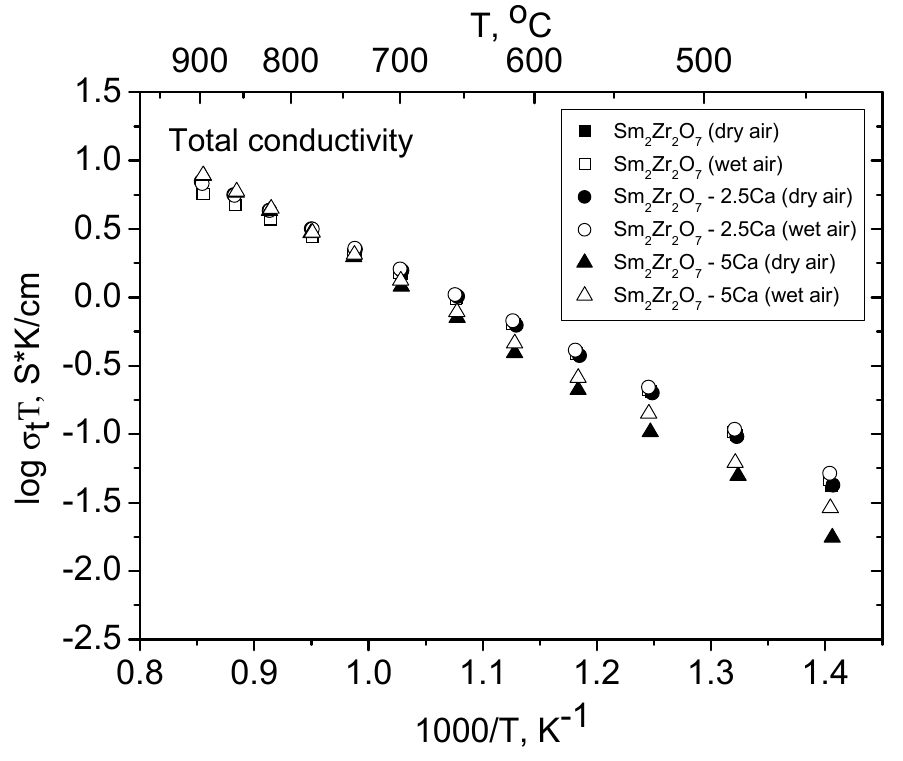
Figure 8. The total conductivity of Sm 2 − x Ca x Zr 2 O 7 − x/2 (x = 0, 0.05, 0.1) in dry and wet air.